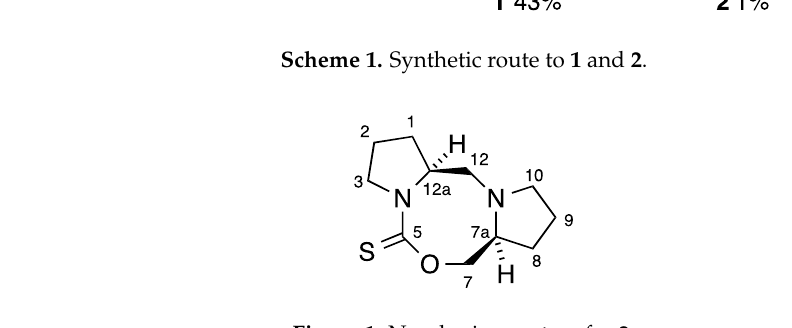
Figure 1. Numbering system for 2. Table 1. NMR assignment for 2.